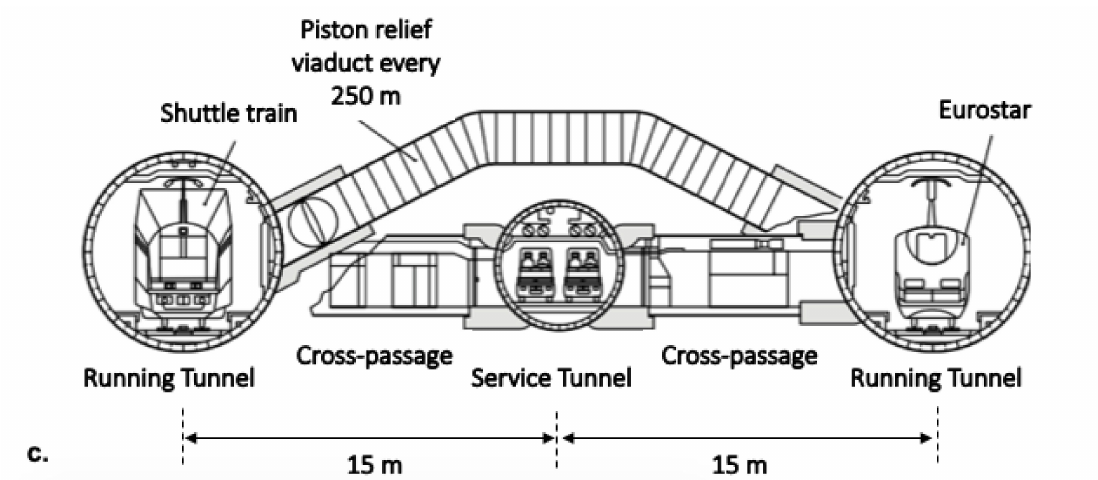
Figure 5. ( a ) Locations of marine boreholes from 1958 to 1987 [41], ( b ) cross section of the Channel tunnel (modified from [47]) and ( c ) tunnel alignment [45].